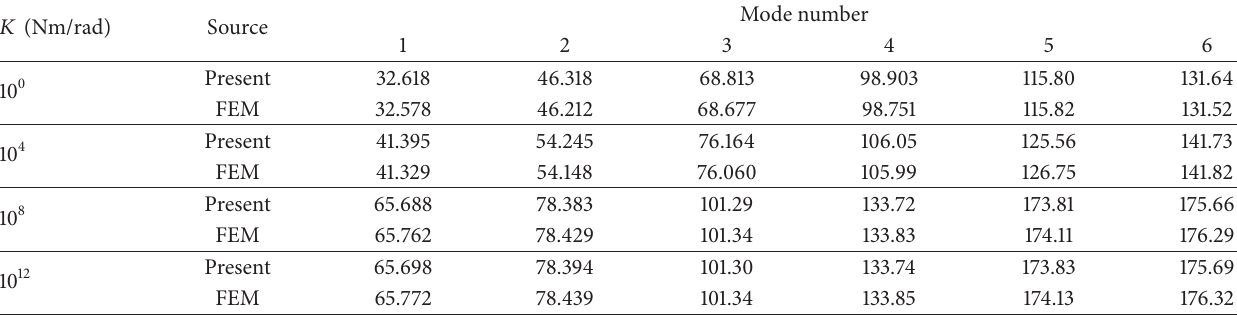
Table 6: Frequency parameters, Ω = 𝜔𝑏 2 (𝜌ℎ/𝐷) 1/2 , for simply supported annular sector plates with uniform rotational restraint along each